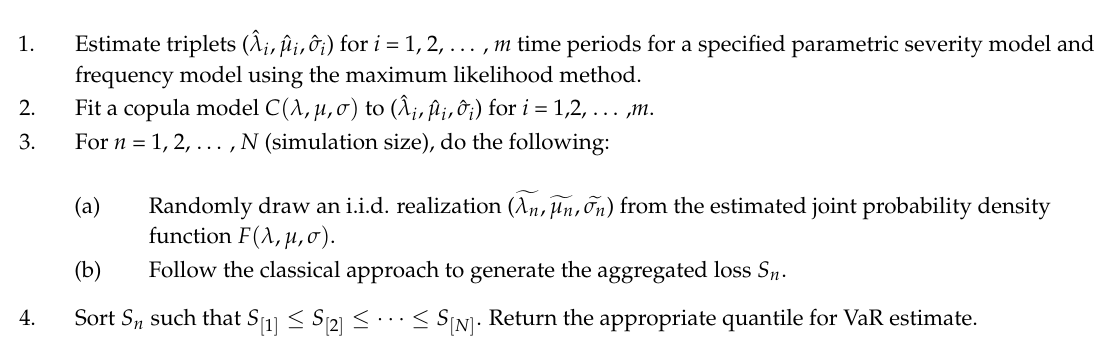
Algorithm 2 Copula-based parametric modeling of frequency and severity (CPFS) VaR